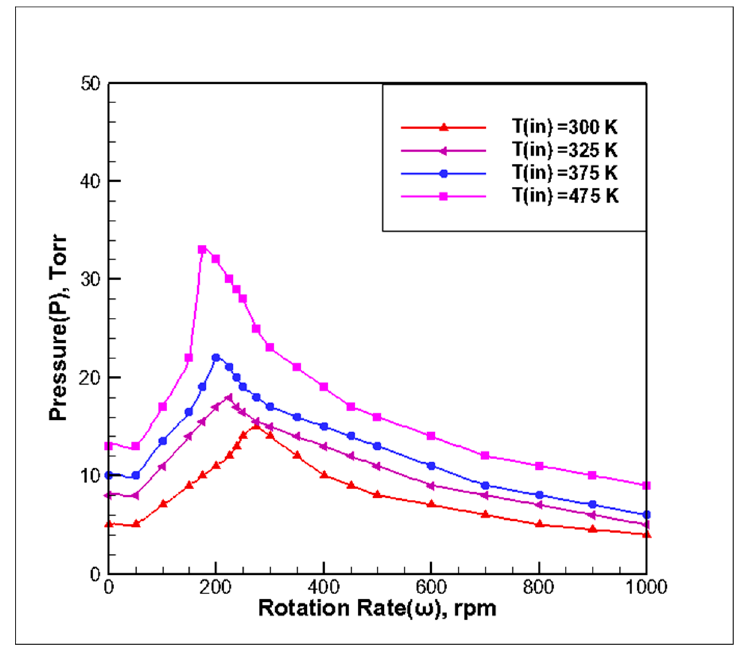
Figure 4. P- ω stability map at different inlet temperatures.